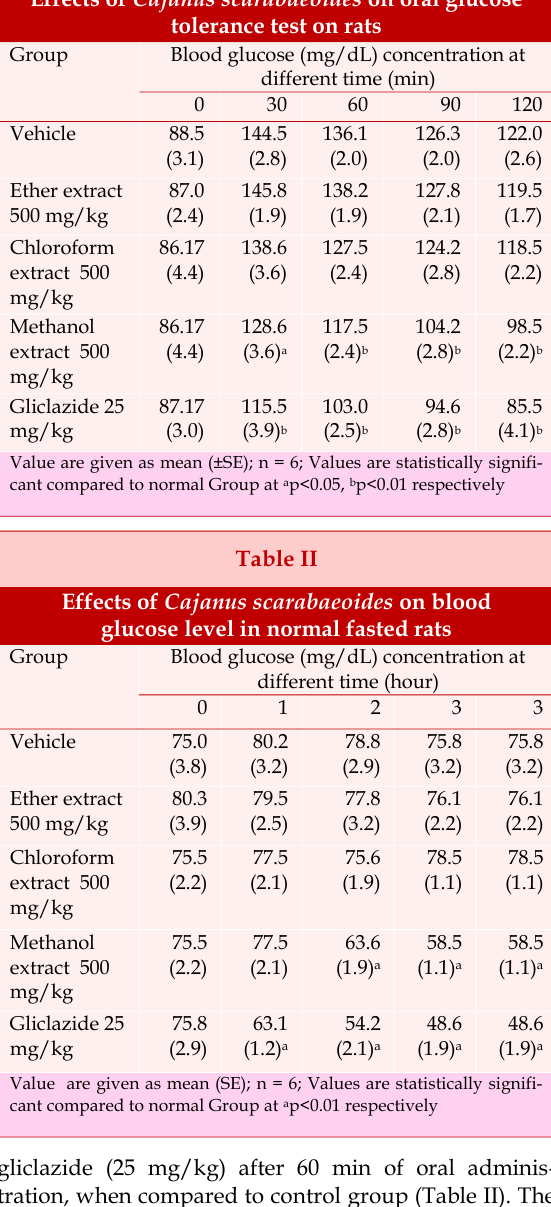
Effects of Cajanus scarabaeoides on oral glucose tolerance test on rats